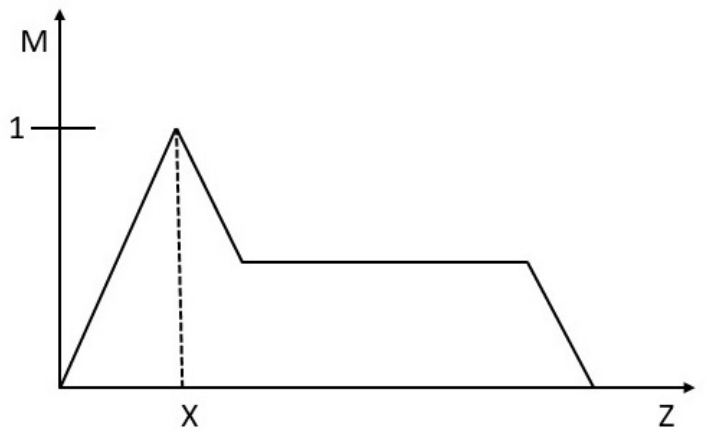
Figure 7. Centroid